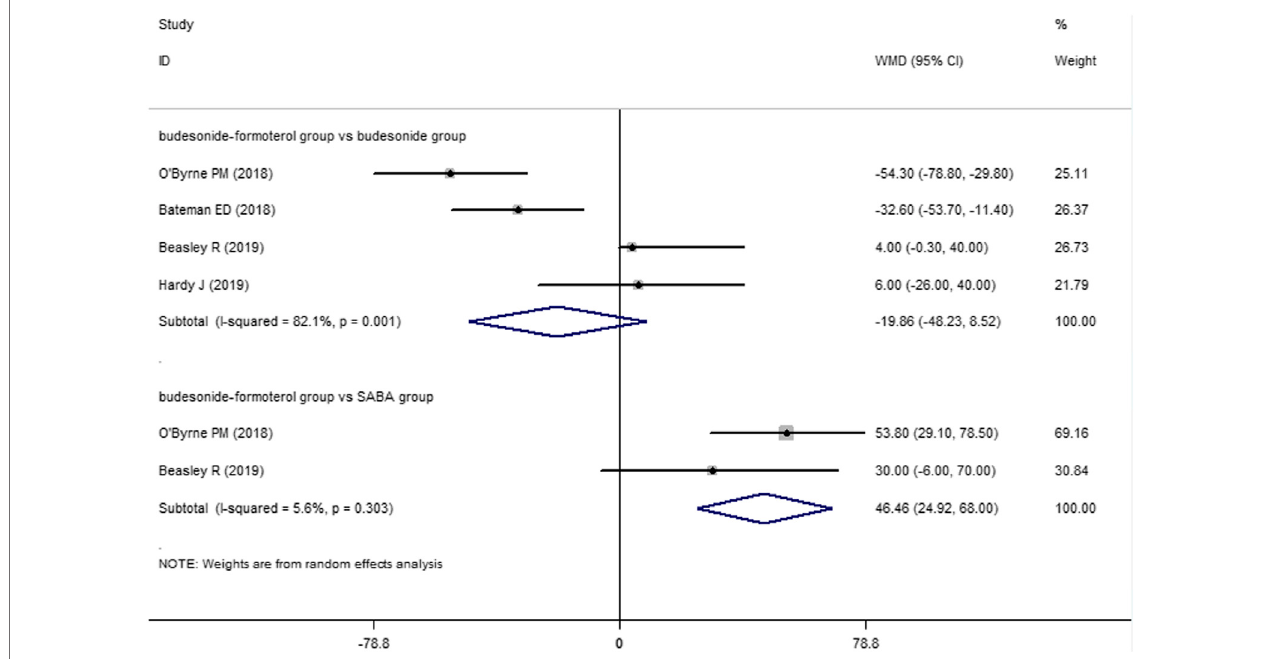
FIGURE 4 | Comparison of the difference of change in the FEV1 in the three treatment groups.